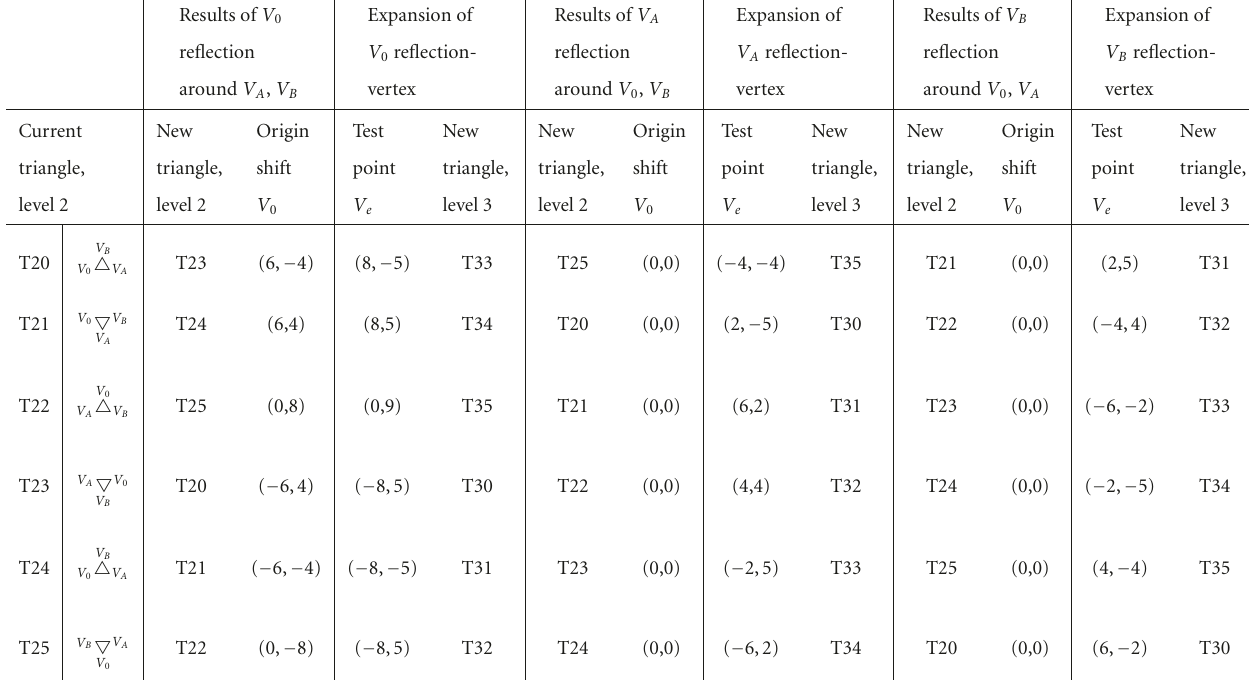
Table A.2: Possible reflections and expansions of level 2